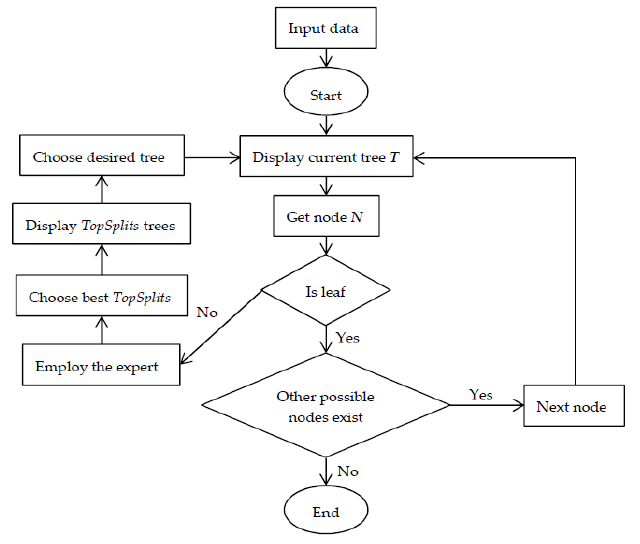
Figure 1. Flowchart of the interactive learning